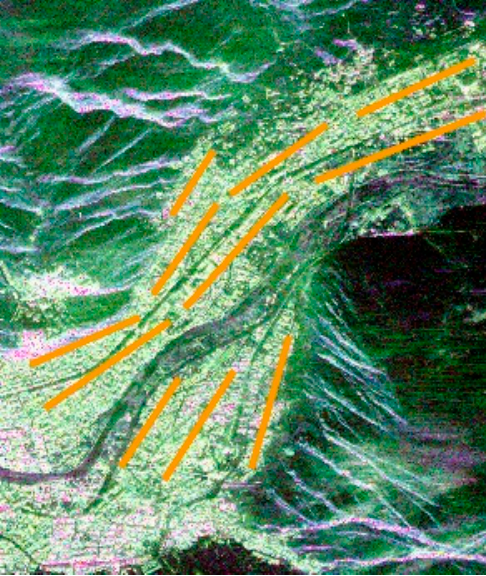
Figure 14. The regions of OB. The orange lines denote the alignment directions of the OB.